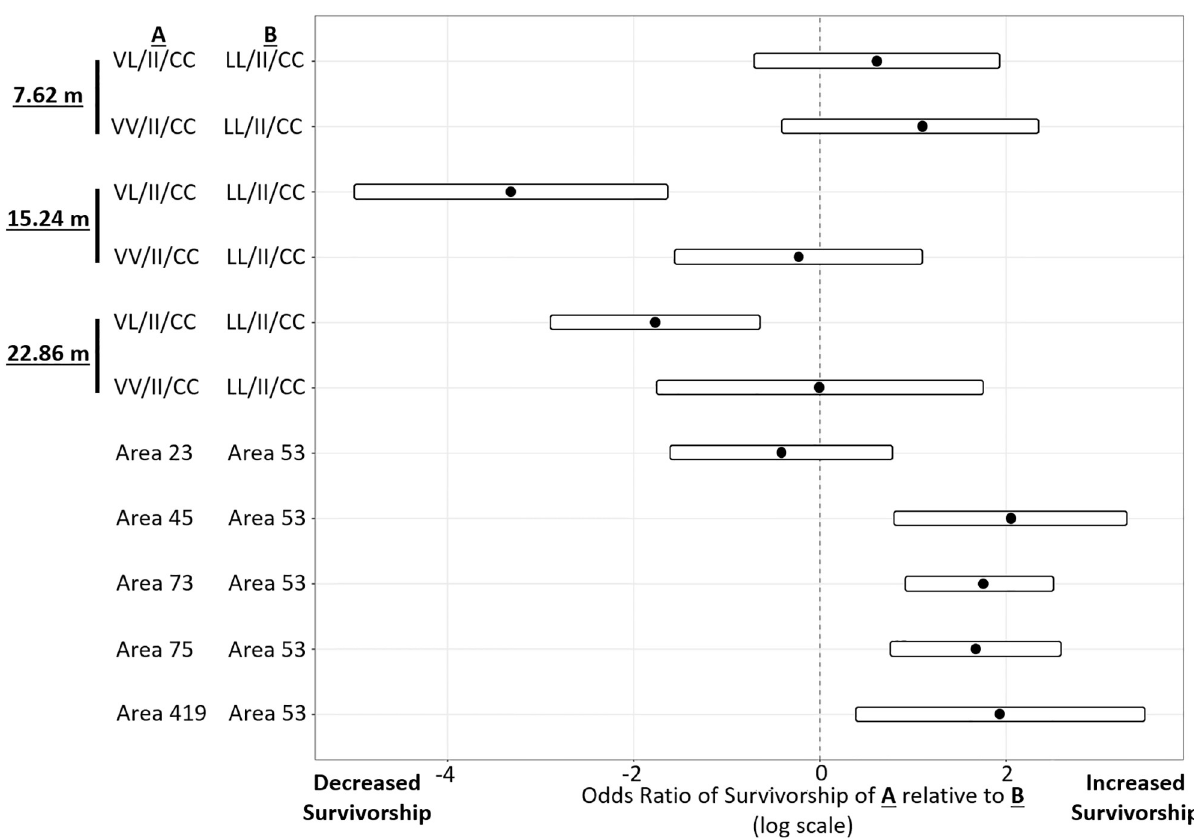
Fig 5. Forest plot of the final model showing odds ratio for female survivorship by the interaction of distance and the tri-locus genotypes, and by operational area. Genotypes or areas under A are compared to the genotype or area reference level, indicated by B ; the genotype with the highest survivorship, LL/II/CC, and Area 53, with the lowest survivorship, were chosen as the reference levels for this plot.